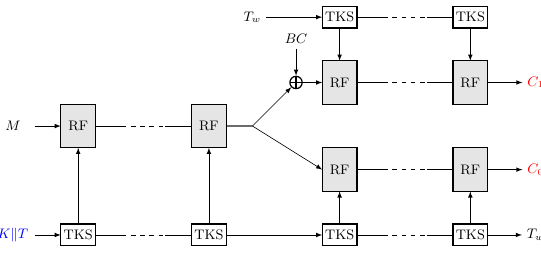
Fig.3: ForkSkinny encryption with selector s = b . A plaintext M , a key K and a tweak T (blue) are used Figure 11: The ForkSkinny framework [ALP + to compute a ciphertext C = C 0 C 1 (red) of twice the size of the plaintext. RF is a single round function k of SKINNY and TKS is round tweakey update function [17]. and BC is a branch constant that we introduce.